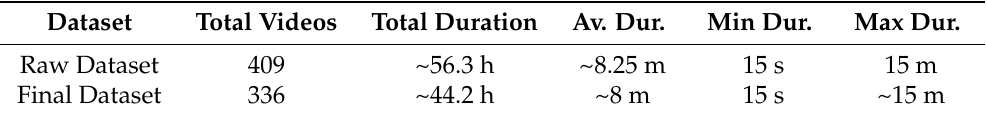
Table 2. Table 2. Video dataset